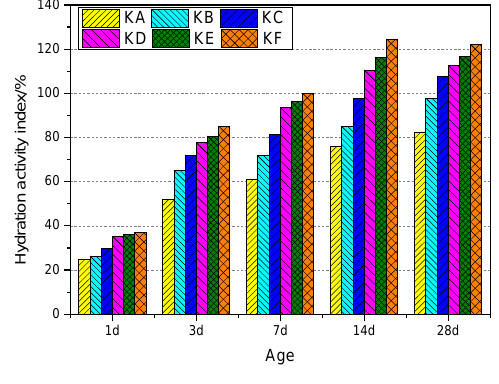
Figure 3. HAI of Figure 3. HAI of GGBS.